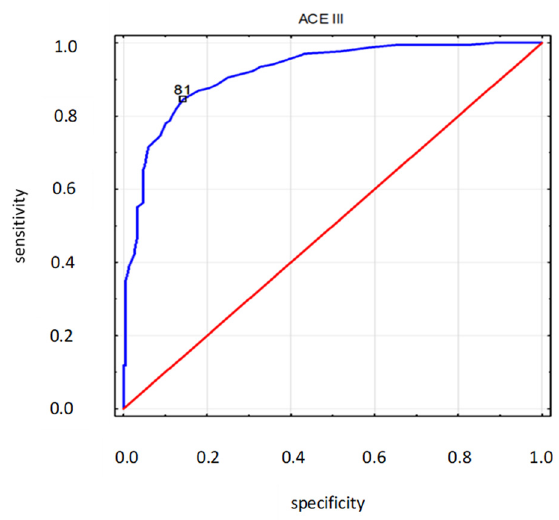
Figure 10. ROC curve (blue) of ACE-III for the MMSE state variable. Diagnostic variable—ACE-III (destimulant); State variable—MMSE: 0—norm (27–30 pts), 1—below the norm (0–26 pts); red— random classifier.